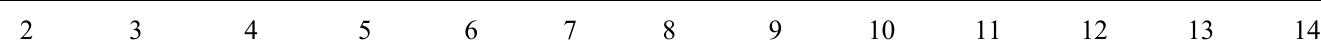
Table 2. Correlations among sport psychological variables, years of practice, and training